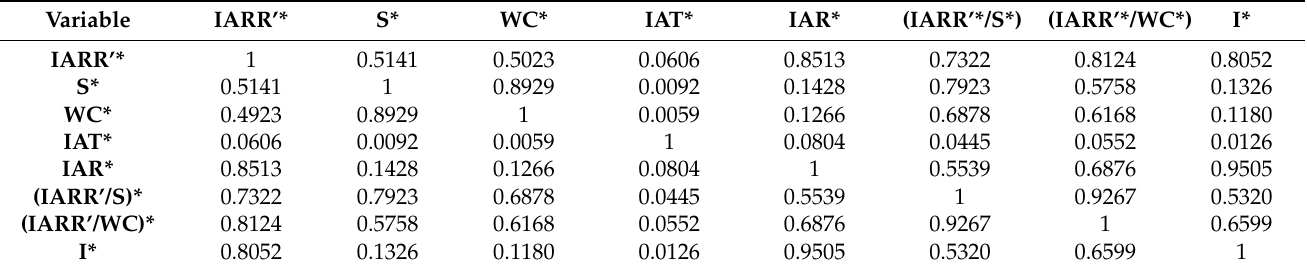
Inter-annual rainfall-runoff residual data of Ol’Dekop (IARR’), inter-annual rainfall (IAR), inter-annual temper- ature (IAT), watershed area (S), watercourse (WC), De martone index (I), * input variable linearized by the Ln function, as follow: X i * = Ln X i